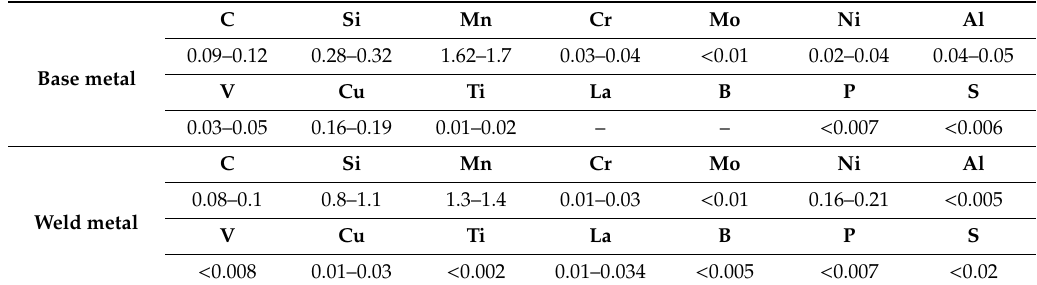
Table 7. Chemical composition of X70 API welds, wt%.